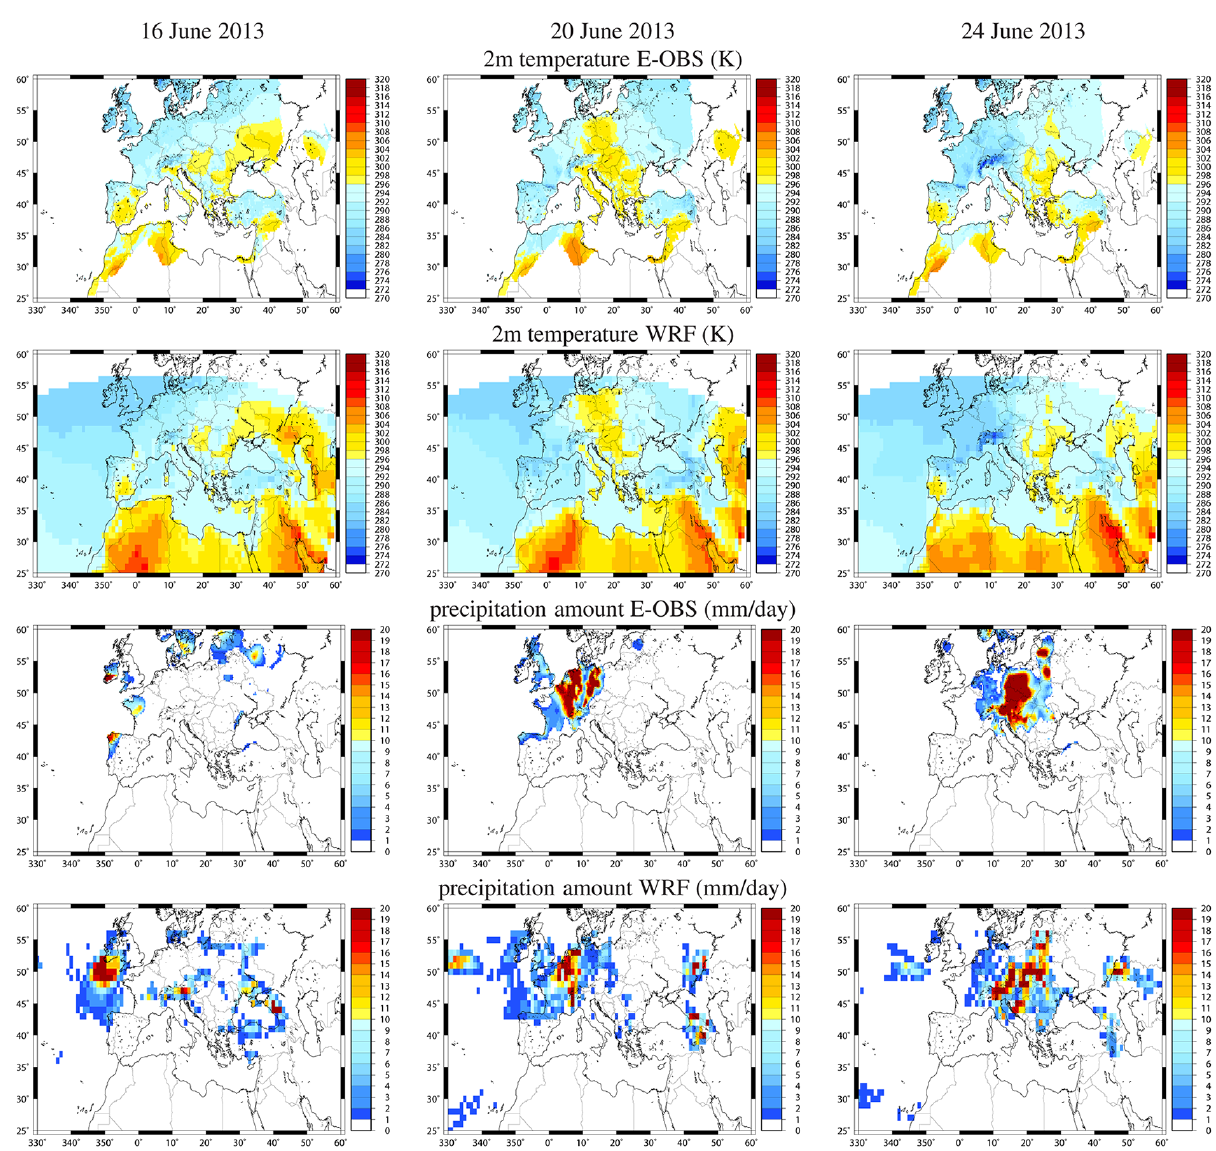
Figure 7. Comparison of daily mean averaged 2m temperature (K) and daily accumulated precipitation amount (mmday − 1 ) with E-OBS (available over land only) and the WRF meteorological